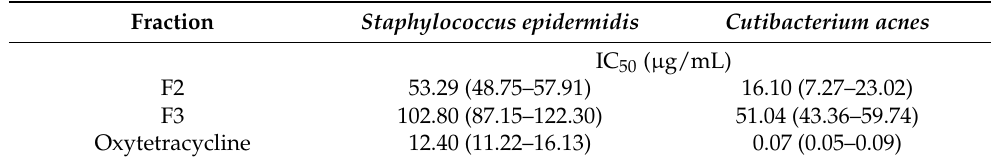
Table 1. Dose–response analysis of Gelidium corneum F2 (water insoluble) and F3 (diethyl ether) fractions against Staphylococcus epidermidis and Cutibacterium acnes .